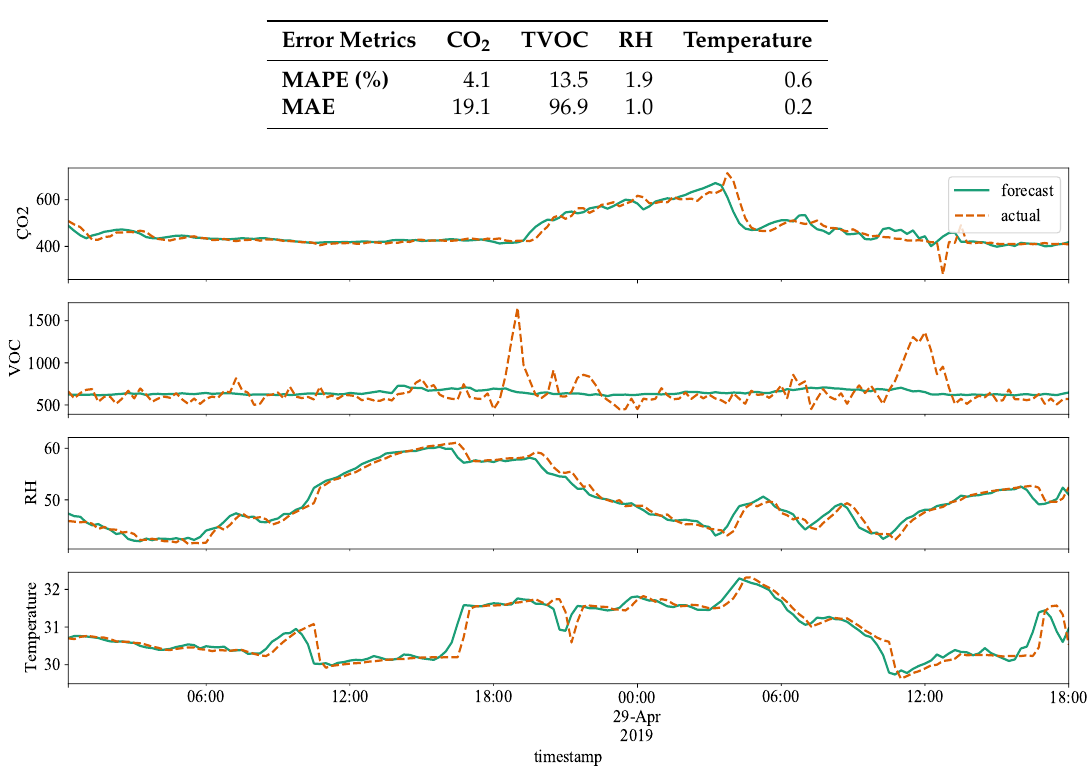
Table 3. Comparison of short-term forecasting results using mean absolute percentage error (MAPE) and mean absolute error (MAE).